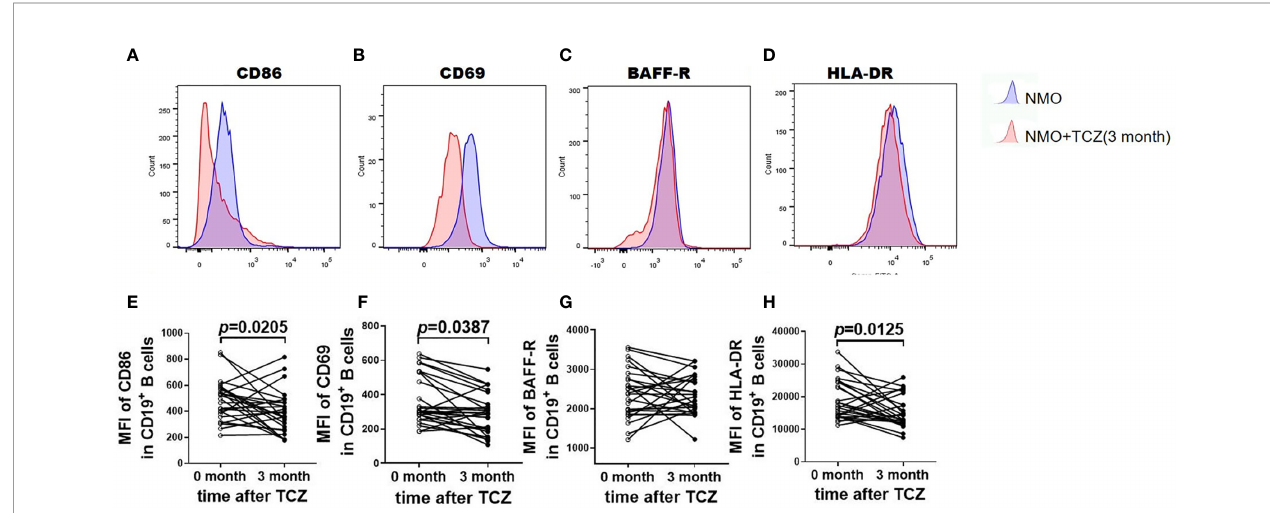
FIGURE 5 | Tocilizumab alters the expression level of activation marker. (A – D) was the representative fl ow cytometric histogram after surface staining activation marker on total B cells (CD19 + ) from NMOSD patients before and after tocilizumab treatment. (E – H) was the quantitative analysis of the mean fl uorescence intensity (MFI) of CD86, CD69, BAFF-R, HLA-DR in CD19 + cells before and after tocilizumab treatment. Difference was considered statistically signi fi cant for P < 0.05. Paired, two-tailed Student ’ s t tests were used,